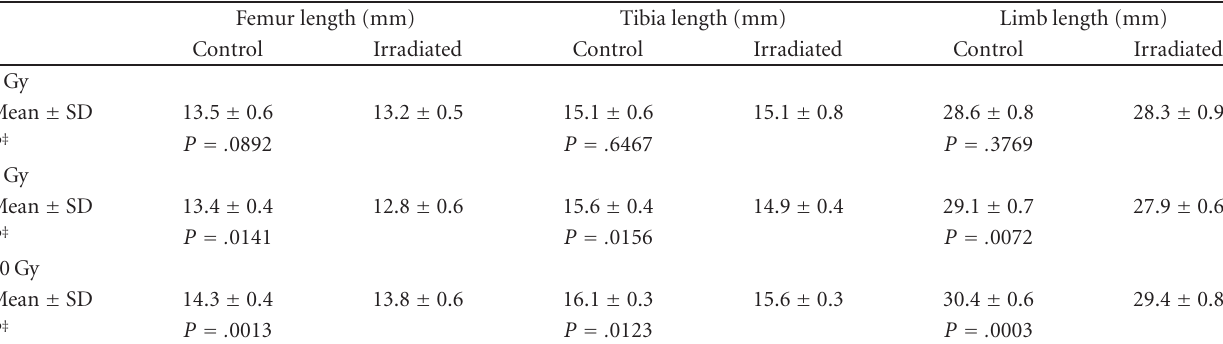
Table 2: Terminal femur, tibial, and total limb length. Data shown are mean ± 1SD; ‡ di ff erences between control and irradiated, tumor- bearing limbs were accepted as significant when P ≤ . 05 by Student’s paired t